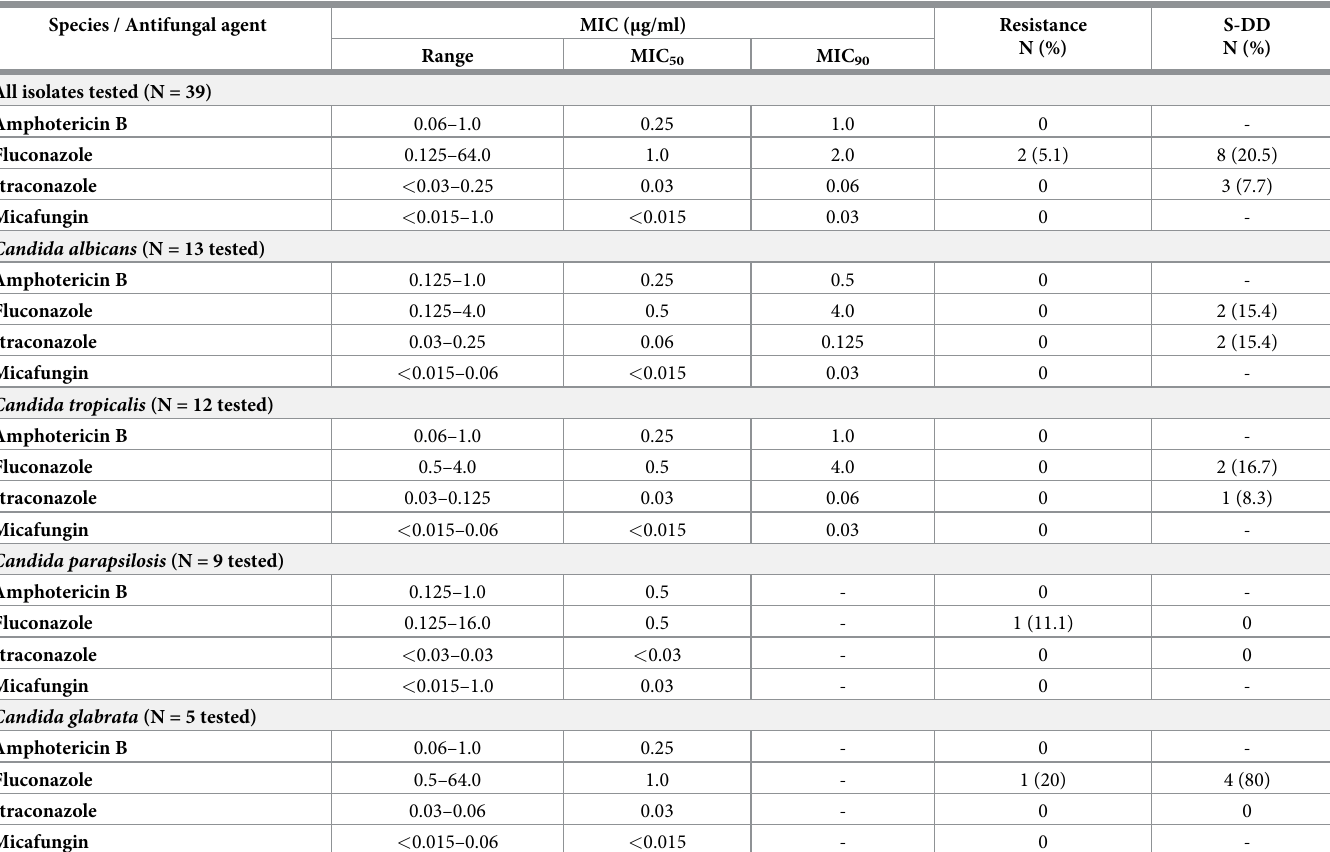
Table 7. Antifungal susceptibility test results for Candida spp.